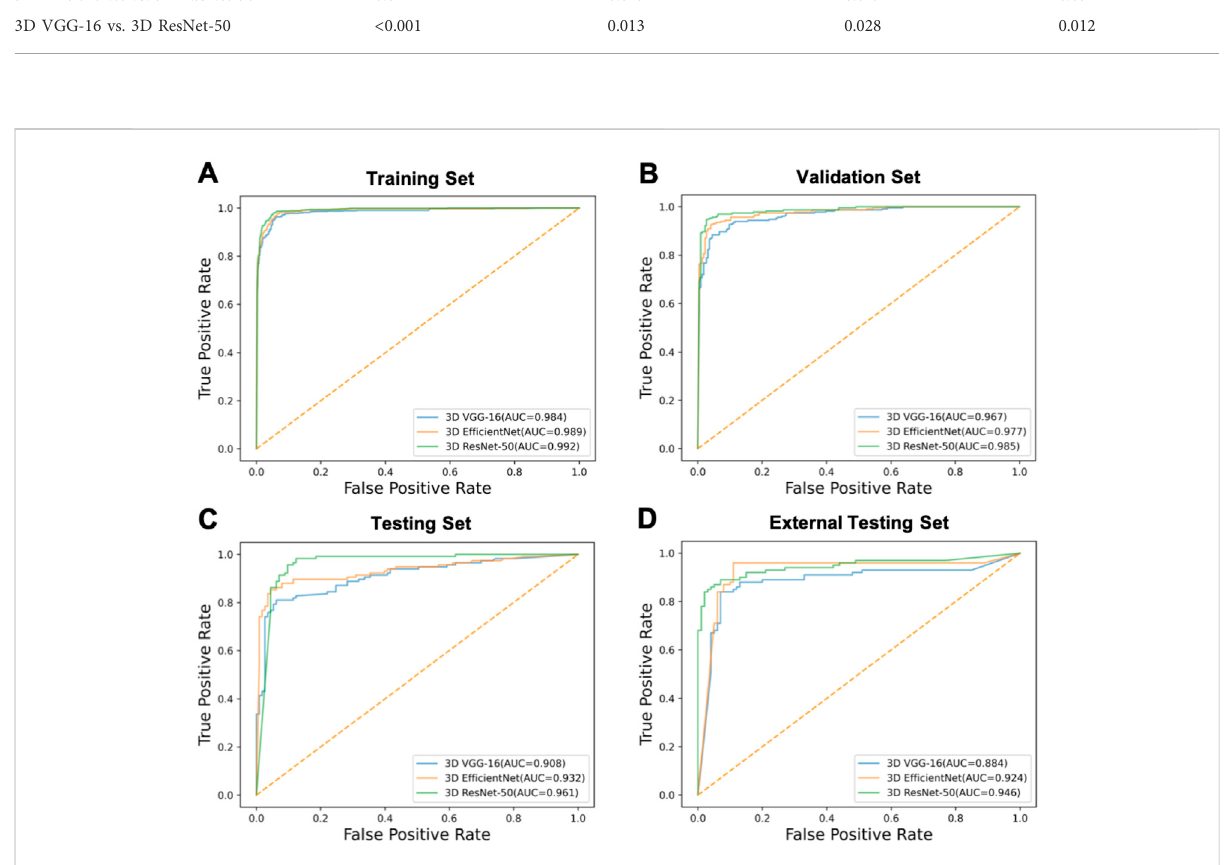
FIGURE 5 The ROC curves of the models. ROC curves of 3D VGG-16, 3D Ef fi cientNet and 3D ResNet-50 models on the (A) training, (B) validation, (C) testing and (D) external testing